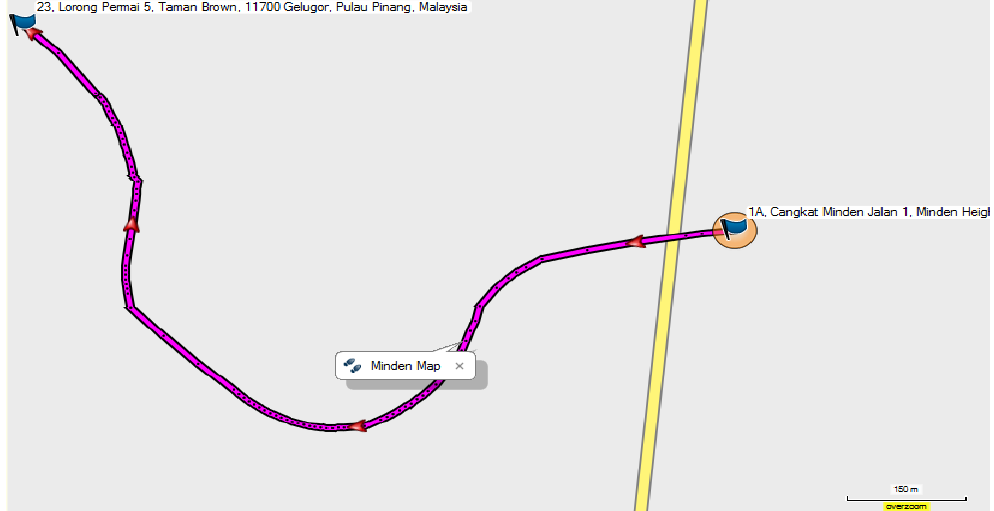
Figure 8. Minden Route from Garmin